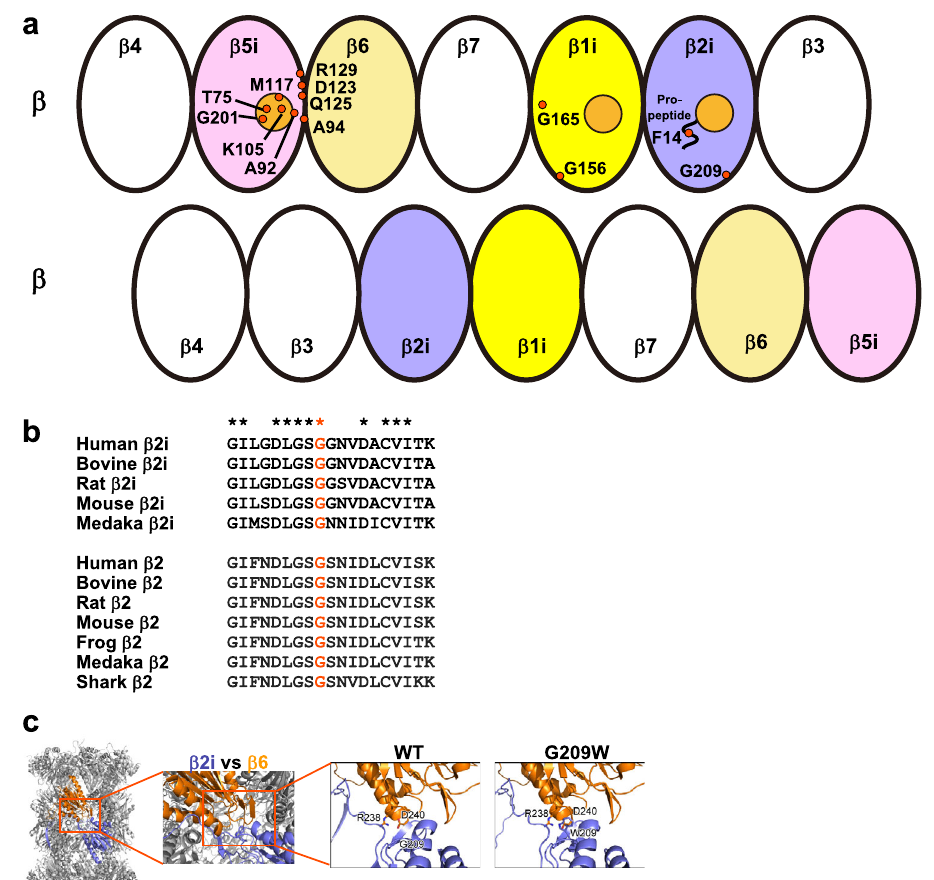
rings in the immunoproteasome (https://infevers.umai-montpellier.fr/web/index.php). The mutant residues are represented by red circles. Catalytic active sites in β 1i, β 2i, and β 5i are marked with orange circles. Notably, PSMB9 G156 and PSMB10 G209 are at the interface of two β rings, while most of mutated residues in PSMB8 are at or around active sites. b Multiple alignments of PSMB10 ( β 2i) and PSMB2 ( β 2) in various species. Conserved amino acids among all these species are indicated by asterisks. G209 in murine PSMB10 and the corresponding amino acids are indicated in red. c The structure model of wildtype and PSMB10 G209W mutant of the 20S complex, based on the β 2i-subunit structure [Protein Data Bank (PDB) ID code 3UNH]. The overall structure of the 20S complex is shown as a ribbon model. β 2i and β 6 subunits are shown as light blue and orange, respectively. W209 and some of the potential interacting residues of PSMB10 G209W mutant are shown in stick